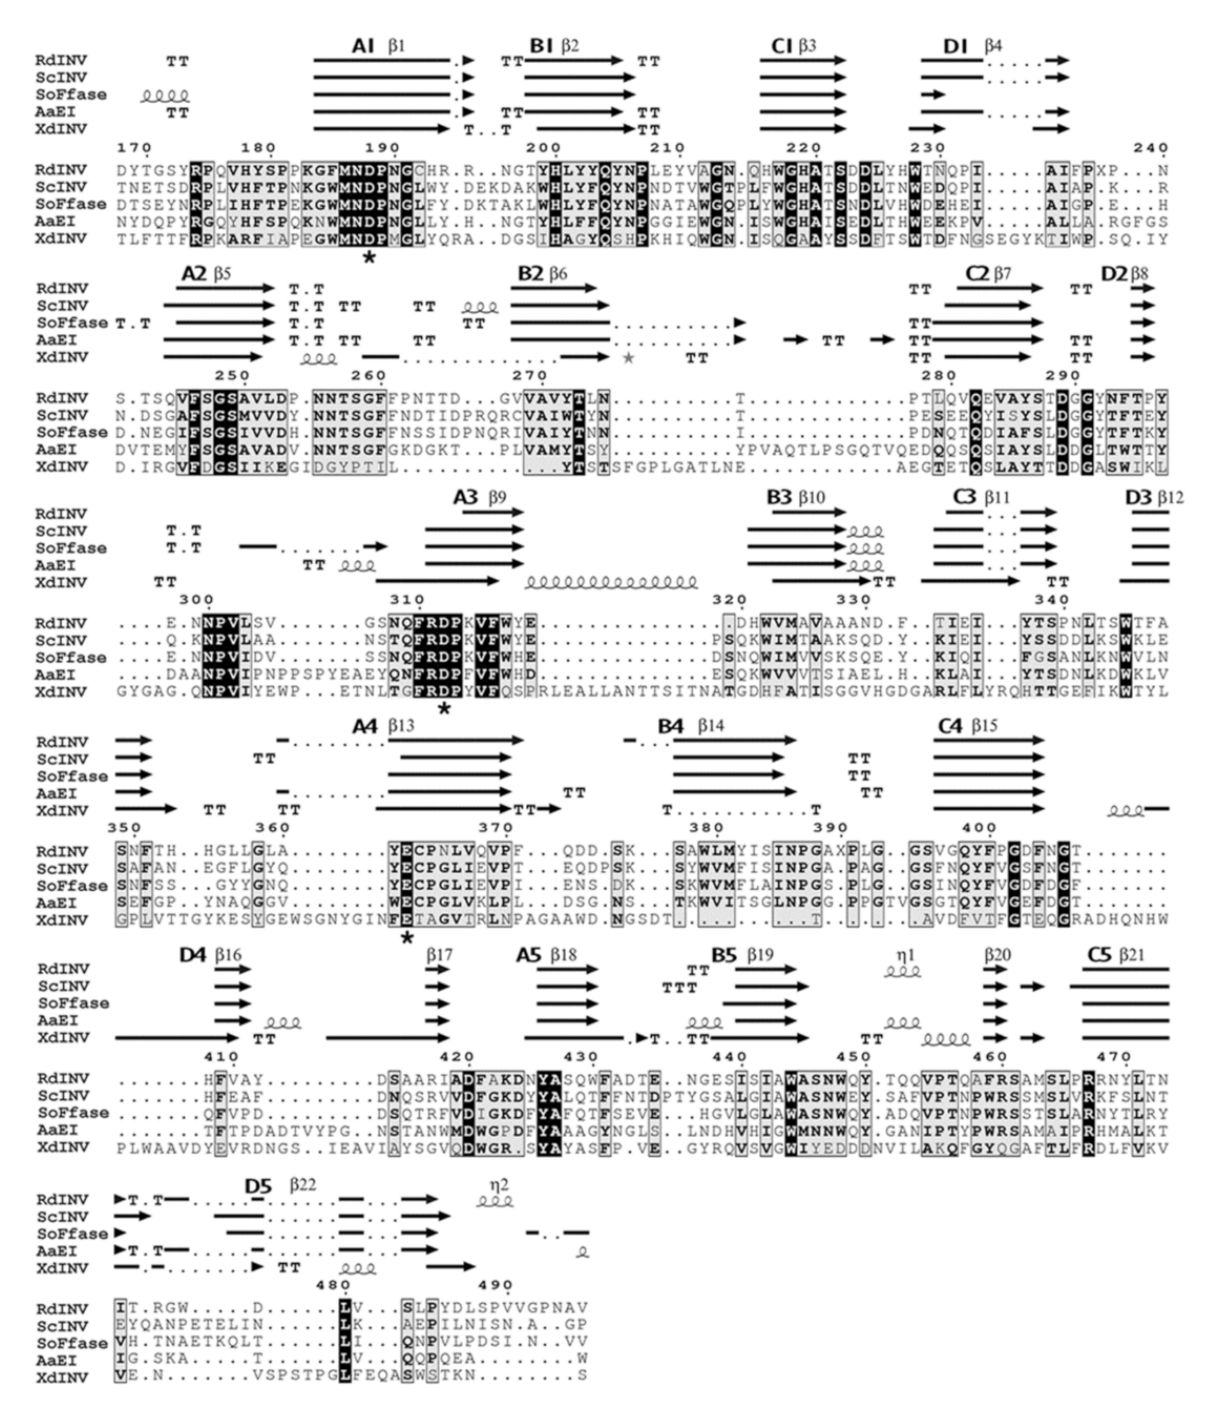
Figure 1. Structural alignment of family 32 of the glycosyl hydrolases (GH32) catalytic domain from yeasts and fungi. Predicted catalytic domain of RdINV (178–496 residues) was superimposed to the S. cerevisiae invertase (ScINV, PDB code 4EQV), Sch. occidentalis β -fructofuranosidase (SoFfase, PDB code 3KF5), A. awamori exoinulinase (AaEI, PDB code 1YM9) and X. dendrorhous β -fructofuranosidase (XdINV, PDB code 5ANN) using ENDscript server. The black squares indicate amino acid similarity as calculated by MSAProbs. Secondary structure elements suggested by DSSP program are shown as squiggles for α -helix, arrows labeled β for β -strands, and strict α - and β -turns depicted by TTT and TT letters, respectively. β -Strands (A–D) of each blade (1–5) of the β -propeller were depicted. Catalytic residues are highlighted with black